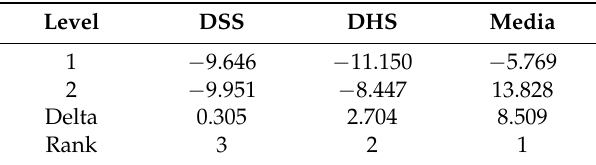
Table 7. S/N ratios for surface roughness using drag finisher.